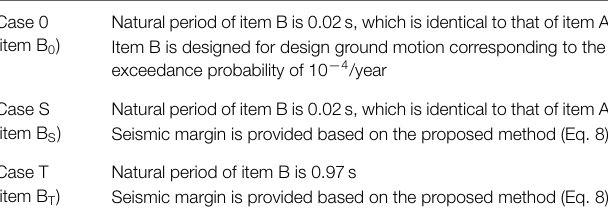
TABLE 3 | Three alternative options for item B .